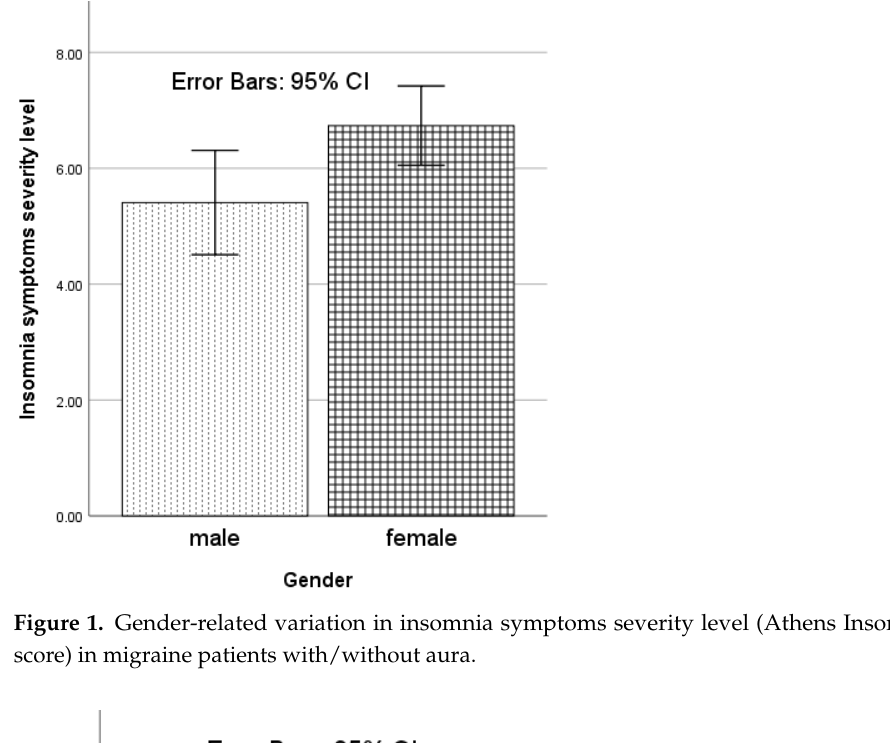
score) in migraine patients with/without aura.